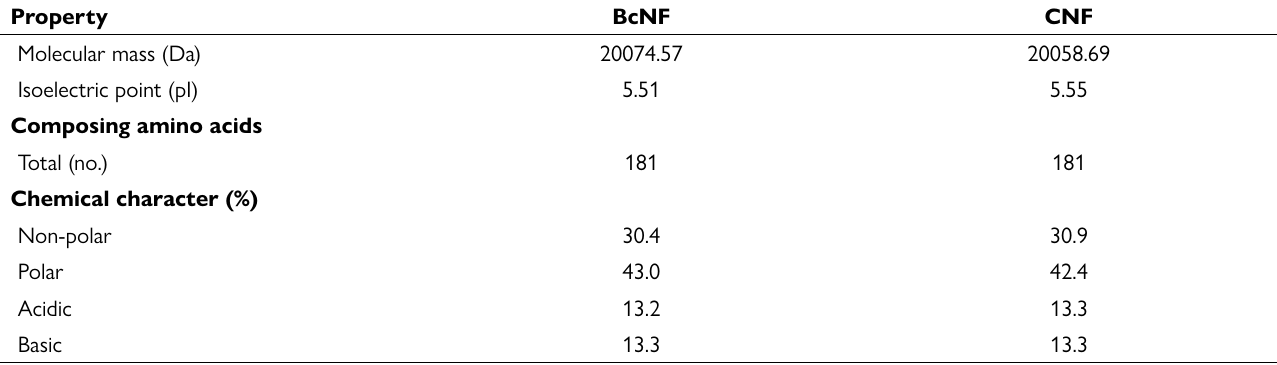
Table 1. Comparison of basic properties of BcNF (sbγPLI from B. constrictor ) and CNF (sbγPLI from C. d. terrificus )